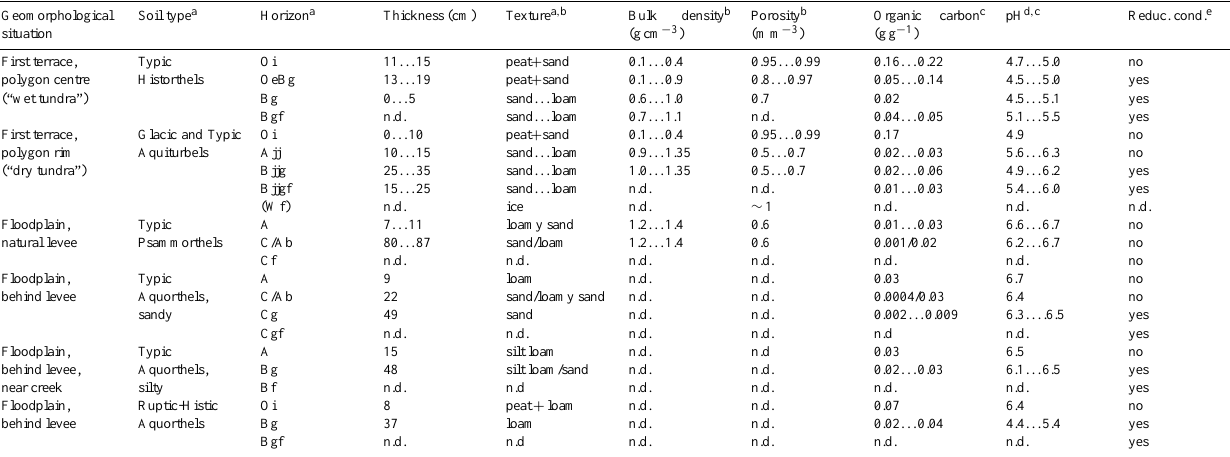
Table 3. Typical soil profile structures and selected properties of the dominant soil types on Samoylov Island. Geomorphological situation